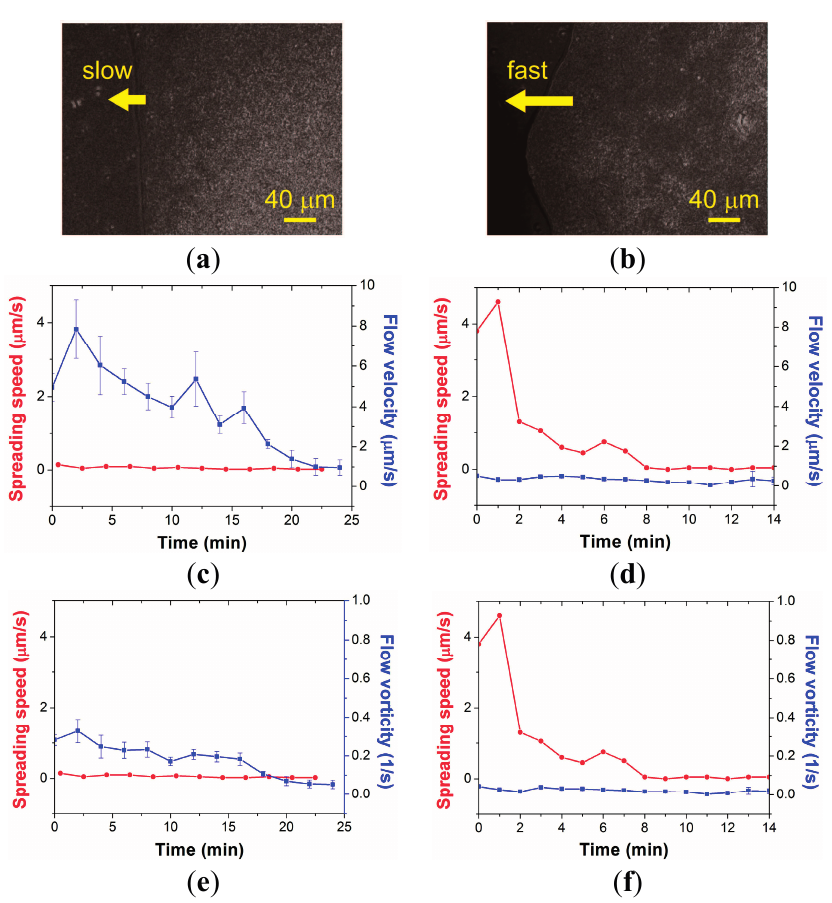
Figure 3. Bright-field image near the advancing edge of the B. subtilis colony in ( a ) slow spreading and ( b ) fast spreading mode. The average flow velocity and vorticity were calculated with the 20th percentile of the raw data near the boundary of the colony and plotted along with the advancing speed of the swarm edge in the course of ( c , e ) slow spreading and ( d , f ) fast